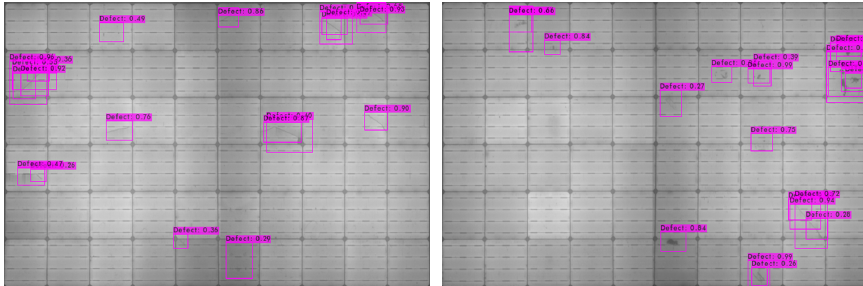
Figure 19. Snapshots of defect detection results of the panel-based approach.